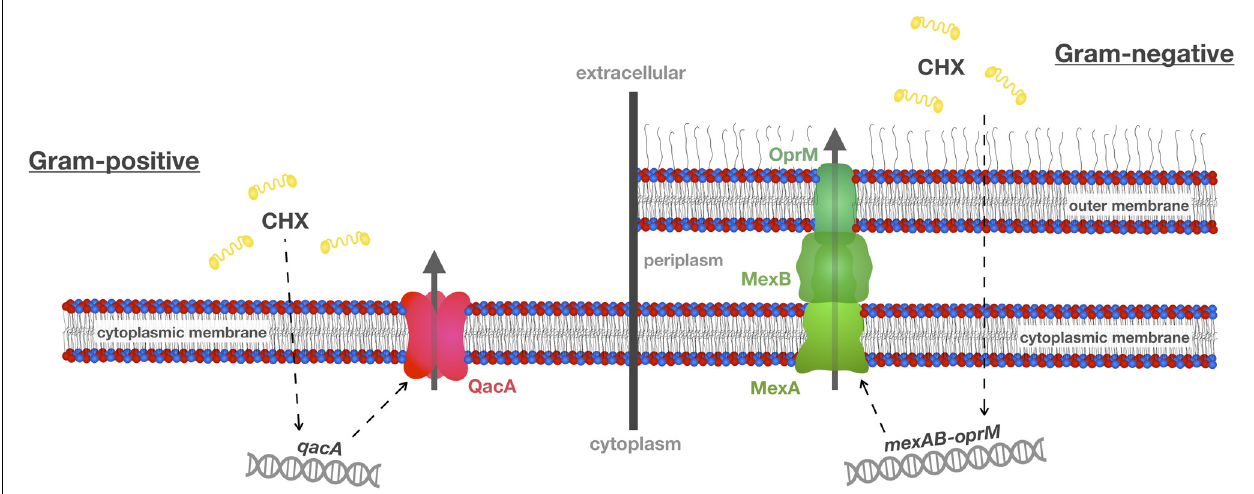
FIGURE 2 | Efflux mechanisms conferring resistance toward CHX. A common resistance mechanism toward antibacterial agents such as CHX is up-regulation of multidrug efflux pumps. This scheme shows two well-known efflux systems, i.e., qacA in Gram-positive S. aureus and mexAB-oprM in Gram-negative P. aeruginosa . These efflux pumps may also be present in oral bacteria and recognize not only CHX as their substrate but also other antiseptics and antibiotics, and, thus, may contribute to cross-resistances between CHX and antibiotics. This scheme was adopted and modified from Venter et al.